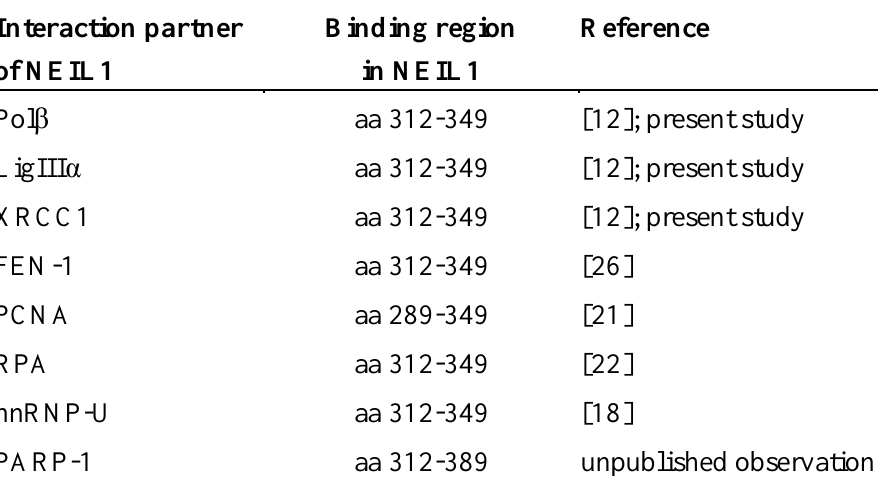
Table 1. NEIL1’s interactions with downstream canonical repair and accessory proteins involved in BER use a common interaction domain in its C-terminus. The relevant references are